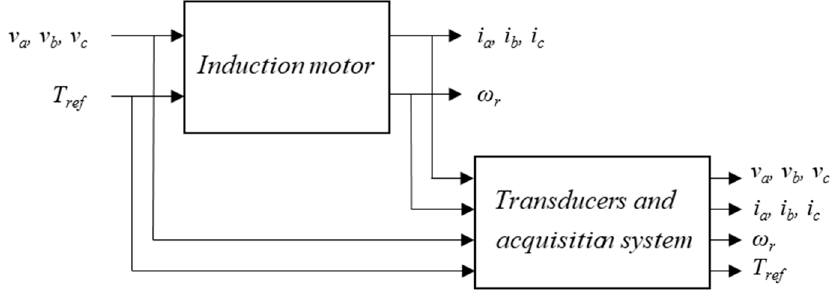
Figure 6. Parameters of the IM used in the experimental tests.